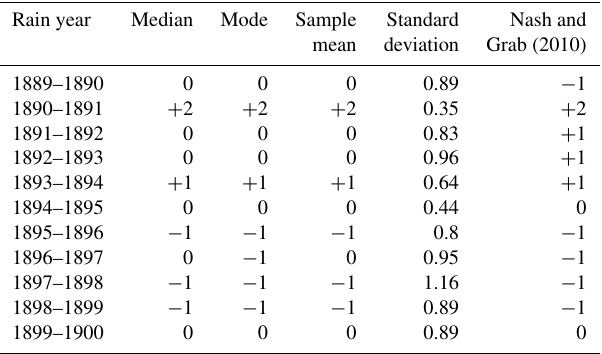
Table 1. Summary statistics of index values applied to the 11 rain years by the 71 postgraduate student raters. Index values in Nash and Grab (2010) are provided for comparison. Mean and median values are rounded to the nearest